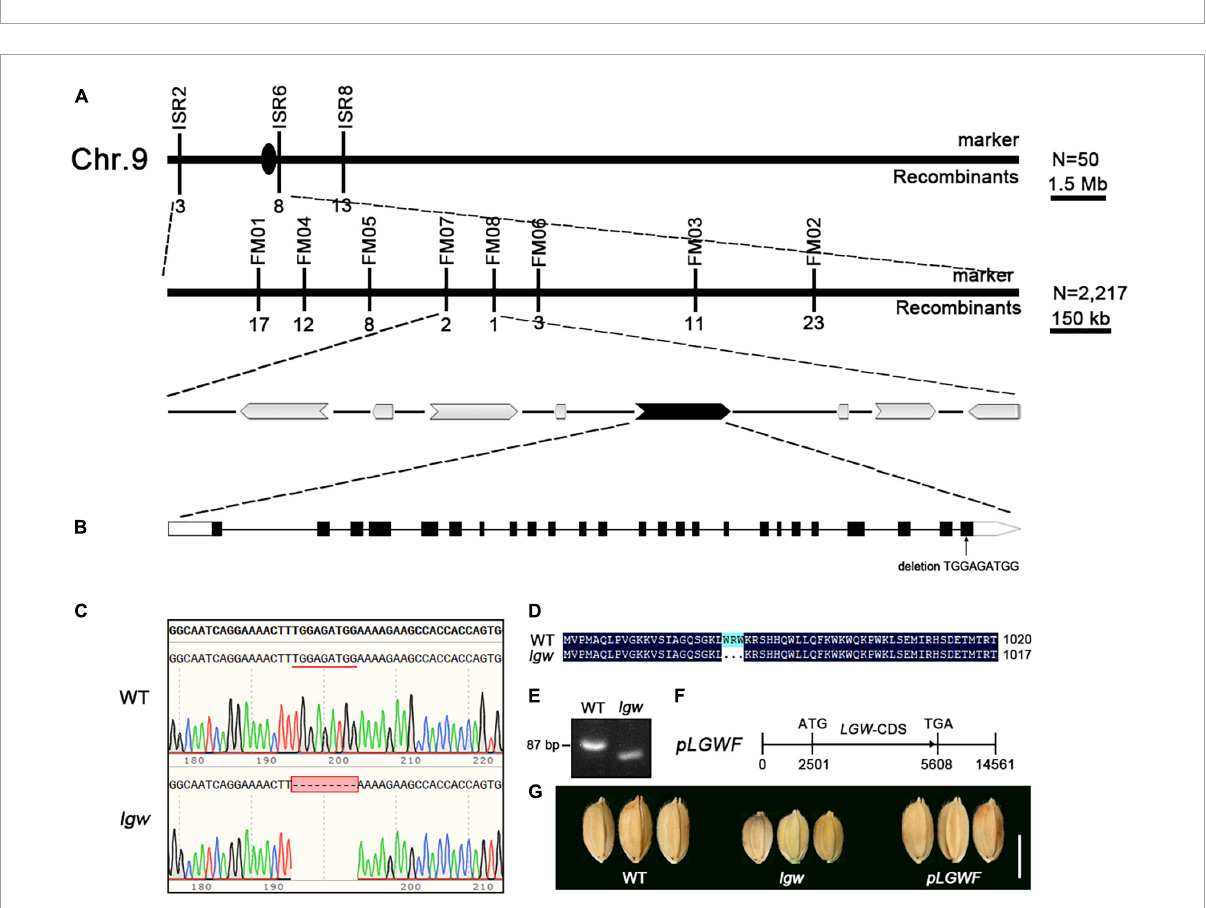
FIGURE3 Map-based cloning of the LGW gene. (A) The LGW locus was mapped on chromosome 9 approximately 114 kb region containing 8 predicted ORFs. The numbers below the molecular markers represent the number of recombinants. (B) A fragment deletion of TGGAGATGG in LOC_Os09g02650. (C) DNA sequence alignments of WT and lgw . (D) Deduced LGW amino acid sequence alignments for WT and lgw . (E) The designed marker for confirming the genotypes of WT and lgw . (F) A construct for complementary assay. (G) Comparing the shape showed seeds recovered from complemented plants was consistent with that of WT. Bar = 0.5